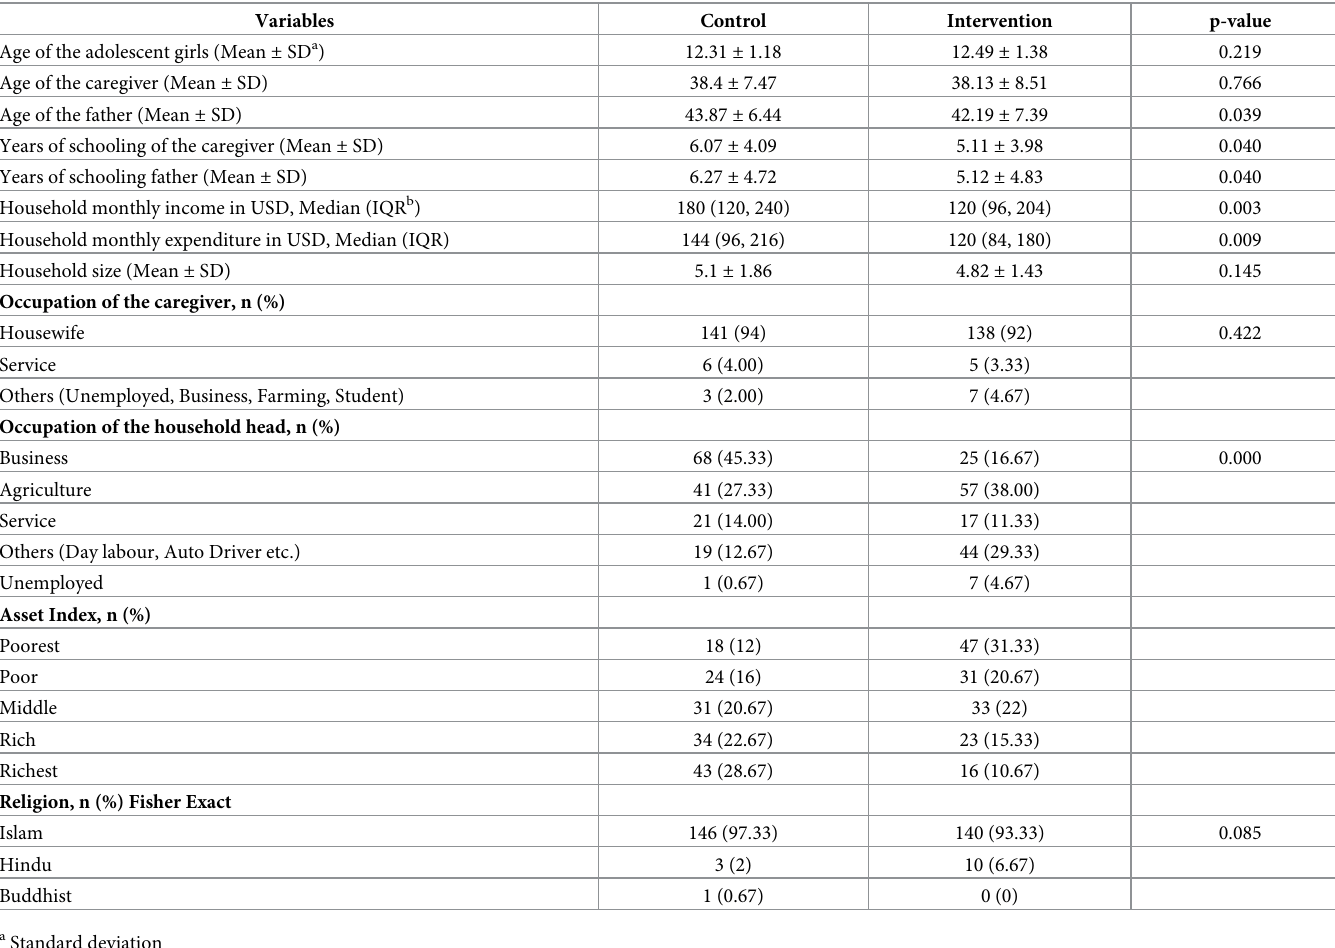
Table 2. Basic characteristics of the study